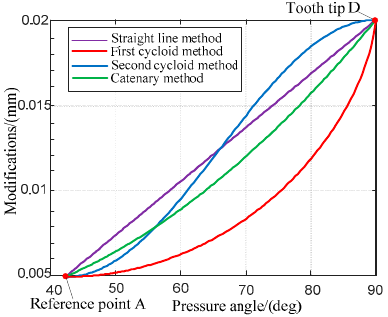
Figure 11. Modification curves of different methods.